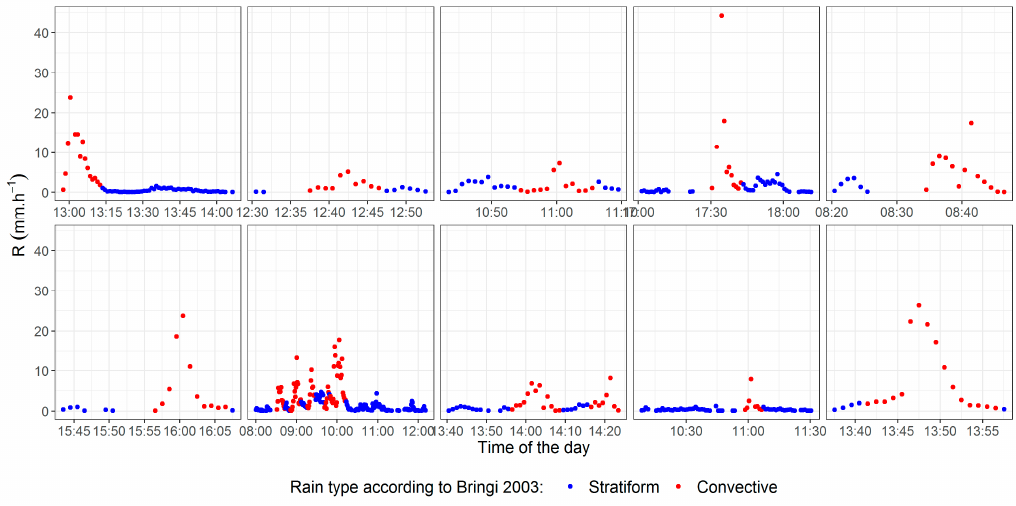
Figure 1. Rain intensity variations for selected events with convective clouds at Fürstenzell. Rain intervals classified as stratiform by Bringi et al. [9] (blue points) were removed from the reference dataset.